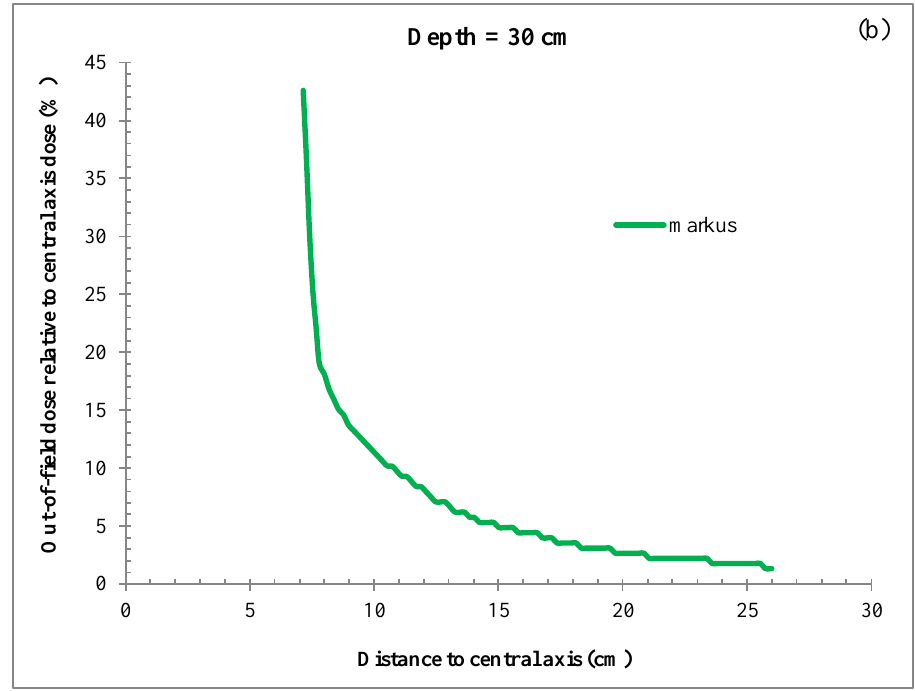
Figure 3. Variation in the out-of-field dose with distance to central axis for field size 10×10 cm 2 at a depth of: a) 15 cm and b) 30 cm using Markus ionization chamber detectors From Figure 3, the Markus detector yields greater values of out-of-field dose with the depth increase. This is more obvious in Figure 4. At a field size of 10×10 cm 2 , the mean out-of-field dose increases from 2.3 to 5.5% at a depth of 30 cm. There is always an increase in the mean out-of-field dose with increase in depth.